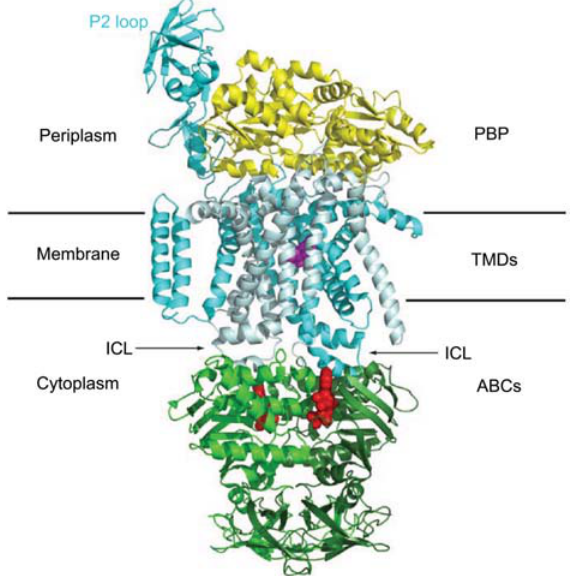
Figure 7 Crystal structure of the complete maltose importer (PDB ID 2R6G), an example of the ABC transporter superfamily. Protein backbone trace is shown, with the PBP (MBP) in yellow, and the two TMDs (MalF and MalG) and ABCs in blue and green, respec- tively, with different tones for each monomer. Atoms of a maltose substrate molecule are shown as magenta spheres occupying the transmembrane binding site. Atoms of two ATP molecules are dis- played as red spheres at their corresponding ABC sites. The position of the membrane (horizontal lines) was chosen to correspond to the predicted buried residues of the